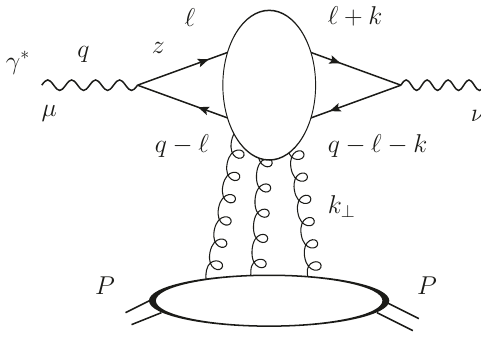
Figure 2 . Depiction of the hadronic tensor in gluon mediated